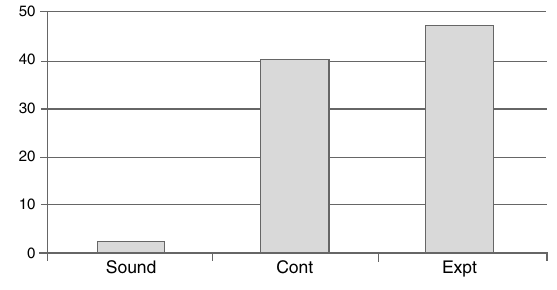
Figure 3 Percentage of outer hair cell damage in each group after their respective treatments.